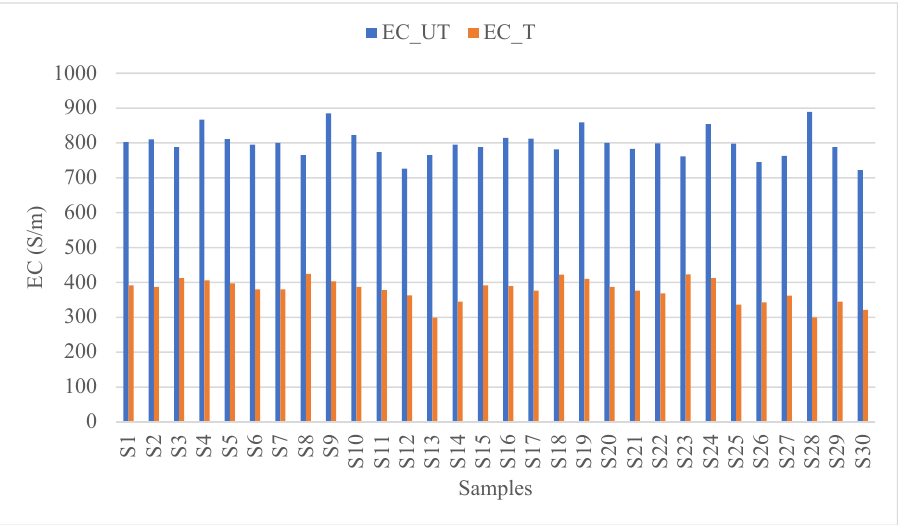
Figure 3. Electrical conductivity of untreated (UT) and treated (T) samples.